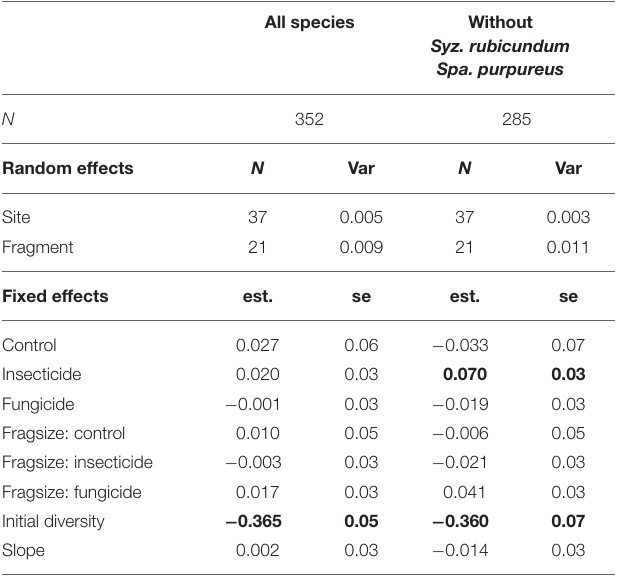
TABLE 1 | Results of linear mixed effects models investigating the influence of experimental treatment and fragment size on changes in alpha diversity